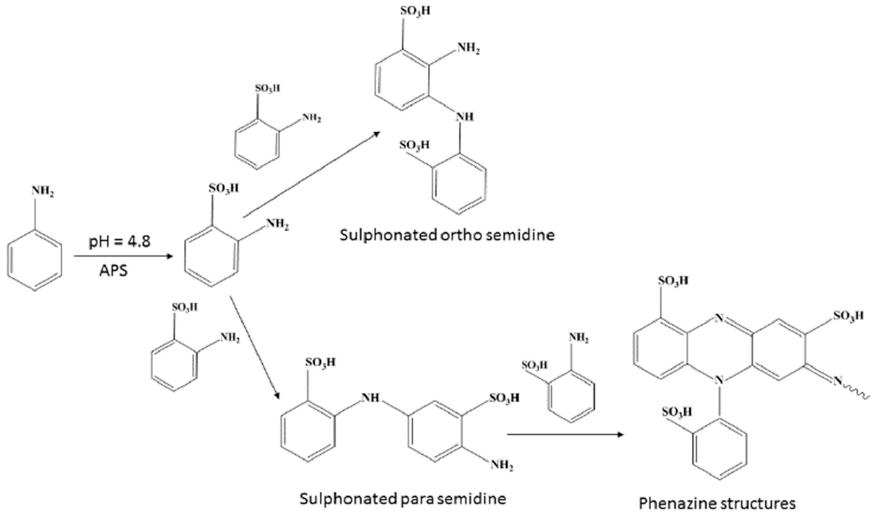
Scheme 1. Reaction pathways for the sulfonated PANI oligomers.